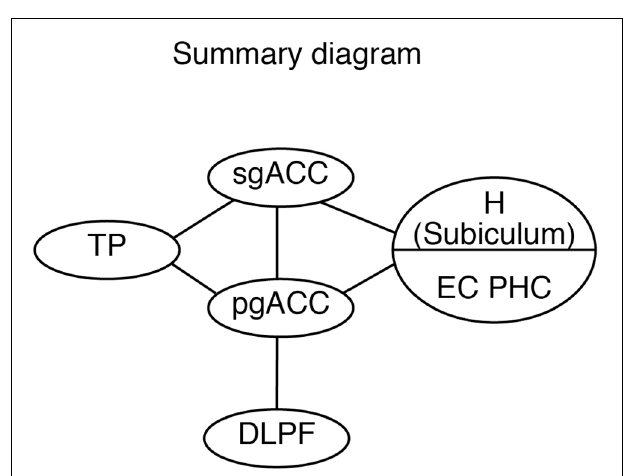
FIGURE 12 | A schematic diagram showing the hierarchical organization of the emotional system, including the pgACC and the sgACC, based on the present and previous studies. DLPFC, dorsolateral prefrontal cortex; EC, entorhinal cortex; H, hippocampus; pgACC, pregenual ACC; sgACC, subgenual ACC; TP, temporal